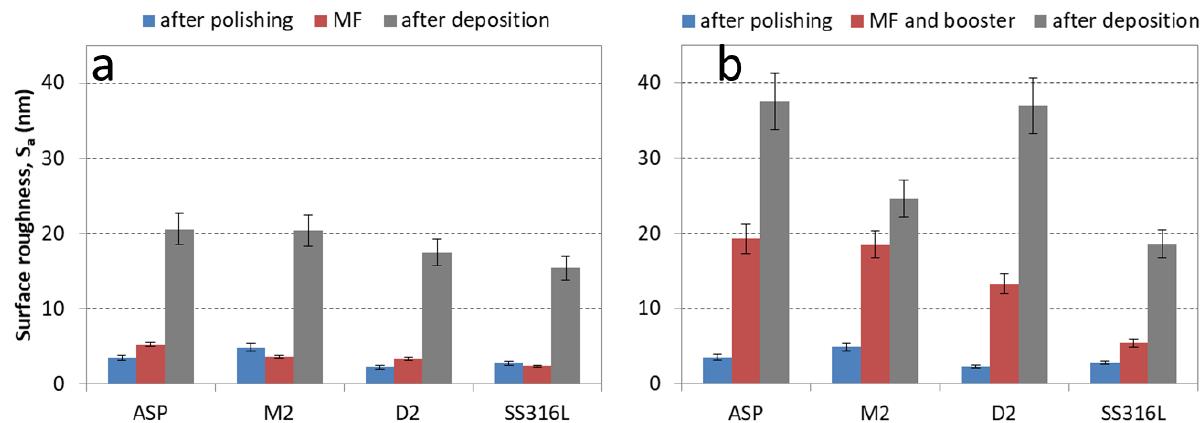
Figure 9. AFM surface roughness of four different steel substrates (ASP, M2, D2, SS 316L) after polishing, ion etching and deposition. One set of substrates was ion etched by the MF technique ( a ) while the other one by MF and booster ( b ). The scan area was 20 µm × 20 µm.